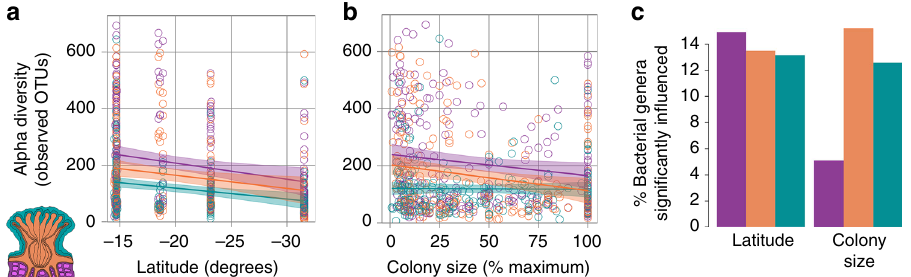
Fig. 2 Effects of latitude and coral relative colony size on coral microbiomes. In all panels, we rely on phylogenetic Generalized Linear Mixed Models (pGLMMs; Methods), which account for potential confounding effects of coral phylogeny, for effect size and signi fi cance. a Microbial community richness (observed OTUs) as a function of latitude and coral anatomy (teal, coral mucus; orange, tissue; purple, skeleton). For visualization of latitudinal effects on richness, linear correlations are shown with colored lines, and their 95% con fi dence intervals are shown by shaded areas. Associations between latitude and microbiome richness were signi fi cant in coral mucus and tissue, but not skeleton (pMCMC: mucus, 0.0018; tissue, 0.0004; skeleton 0.468; pGLMM effect sizes: mucus, 0.026; tissue, 0.035; skeleton, 0.007). b Microbiome richness as a function of coral colony size relative to the maximum recorded size for each species and coral anatomy. Relative colony size vs. microbiome richness was visualized with linear regression. A negative association between coral relative size and microbiome richness was signi fi cant in tissue and skeleton, but a positive association in mucus was not signi fi cant (pMCMC: mucus, 0.86; tissue, 0.0008; skeleton, 0.02; pGLMM effect sizes: mucus, 0.028; tissue, − 0.591; skeleton, − 0.392). c Percent of tested microbial genera signi fi cantly associated with latitude and colony size in phylogenetically-controlled pGLMMs (Supplementary